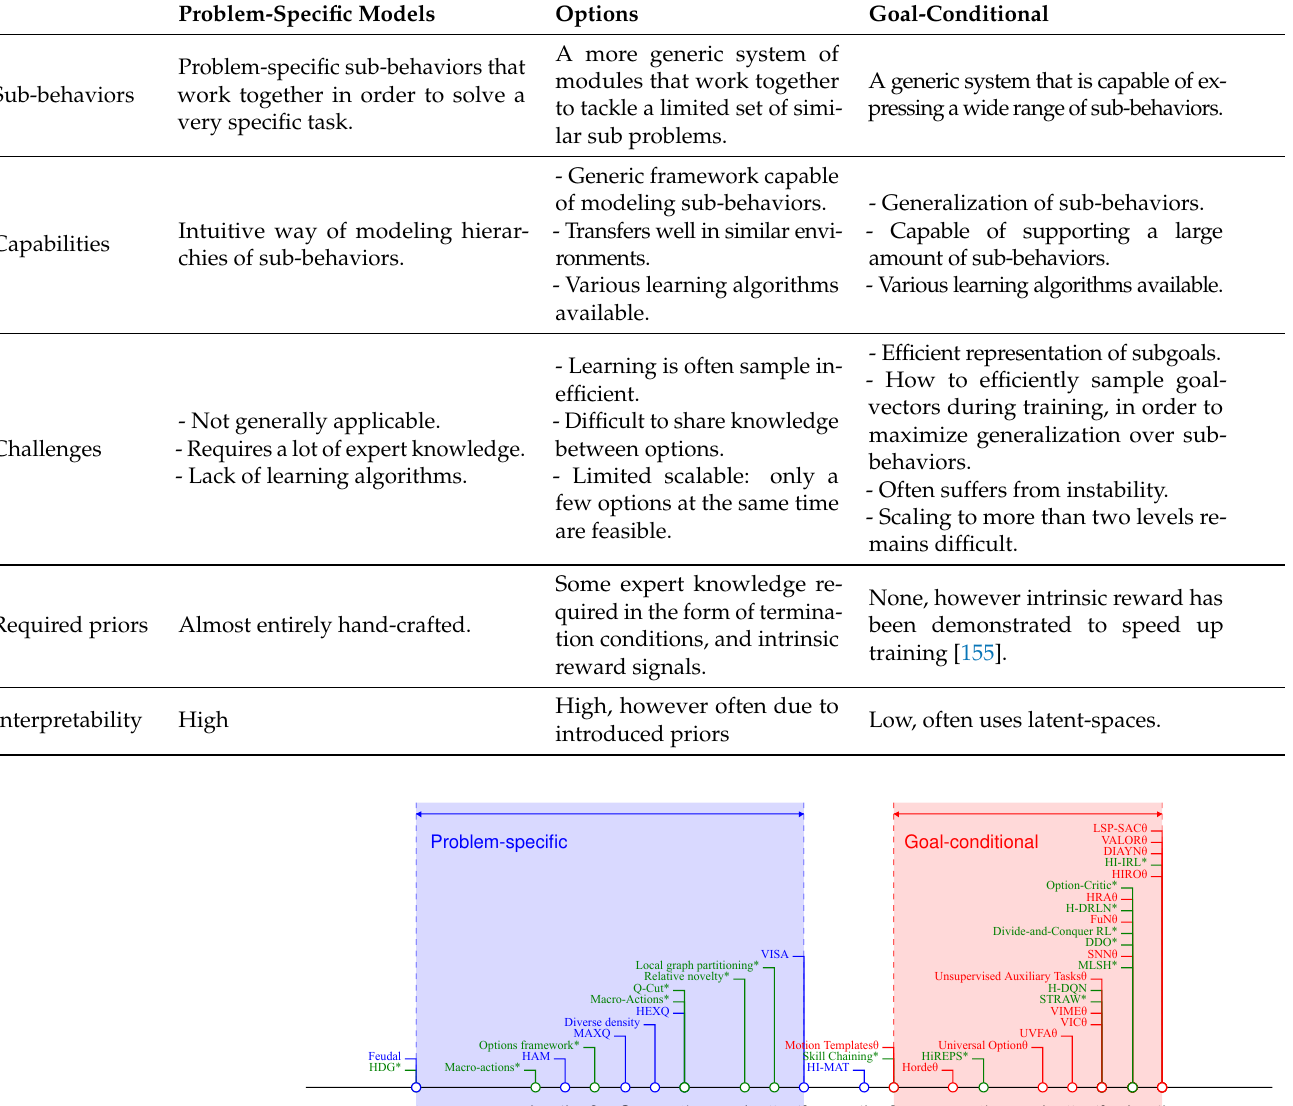
Figure 10. Timeline of common HRL algorithms. The problem-specific models (blue) have started interest in the area, but have somewhat lost interest. Goal-conditional ( θ , red) algorithms are cur- rently the most common approach, while the options framework ( ∗ , green) has remained a popular framework throughout the whole HRL